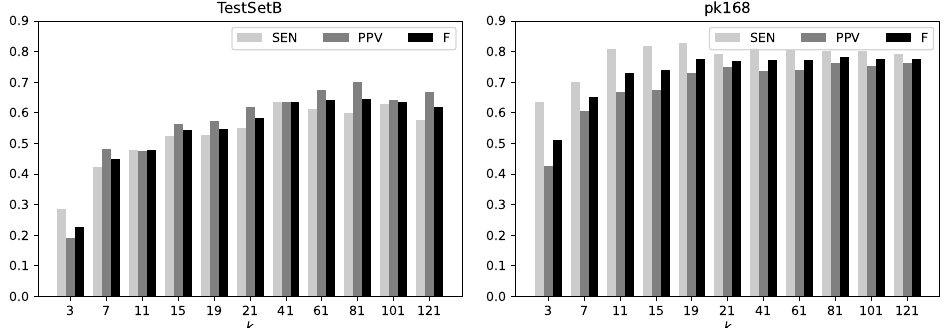
Figure 4. The accuracy of the FNN model with different lengths of k -mers on the TestSetB dataset ( left ) and the pk168 dataset ( right ). SEN , sensitivity; PPV , positive predictive value; F , the F -value based on SEN and PPV